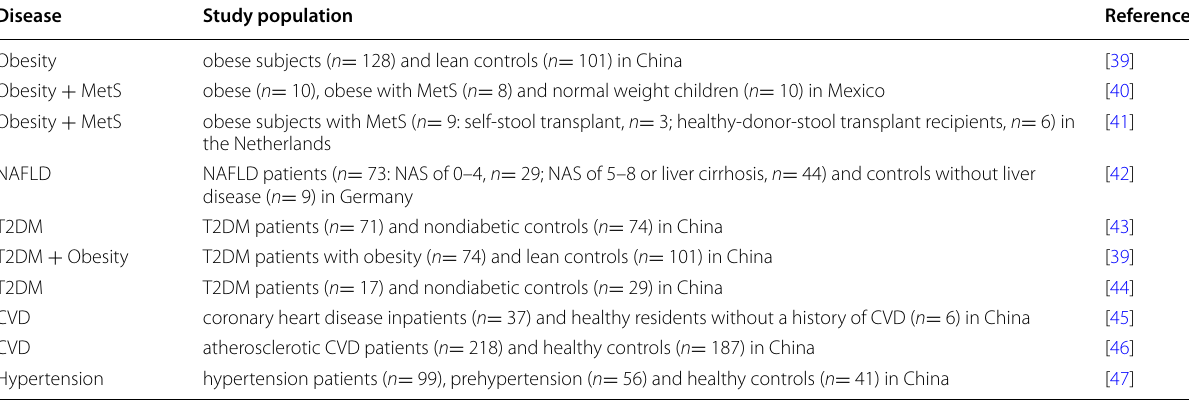
Abbreviations : MetS Metabolic syndrome, NAFLD Non-alcoholic fatty liver disease, NAS NAFLD Activity Score, T2DM Type 2 diabetes mellitus, CVD Cardiovascular disease.